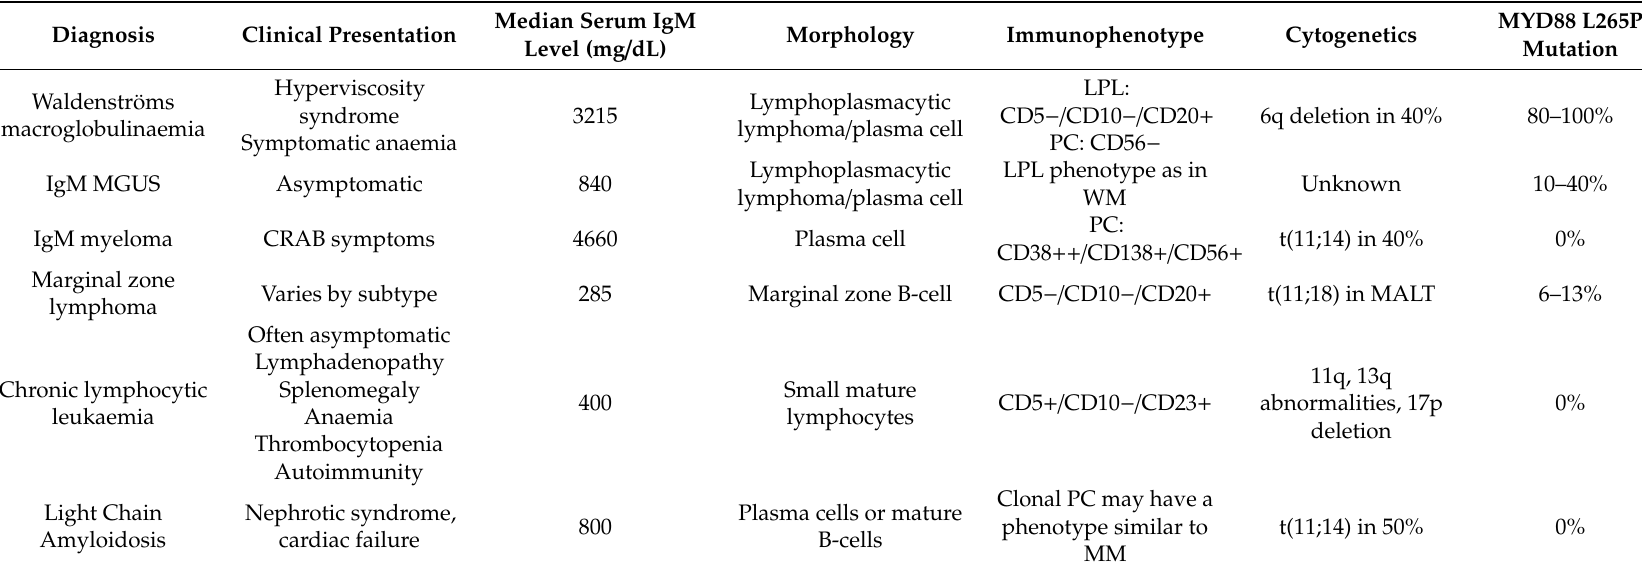
Table 1. Clinicopathologic characteristics of haematologic neoplasms associated with immunoglobulin M